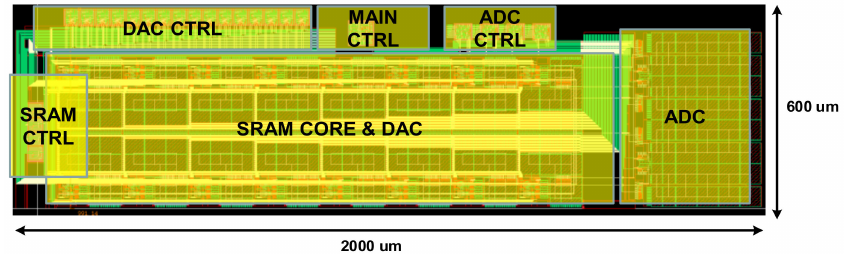
Figure 9. Processor-In-Memory Layout.